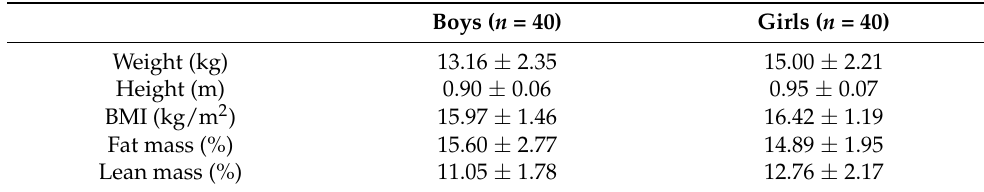
Table 4. Sample characteristics. Average age 3.1 years.